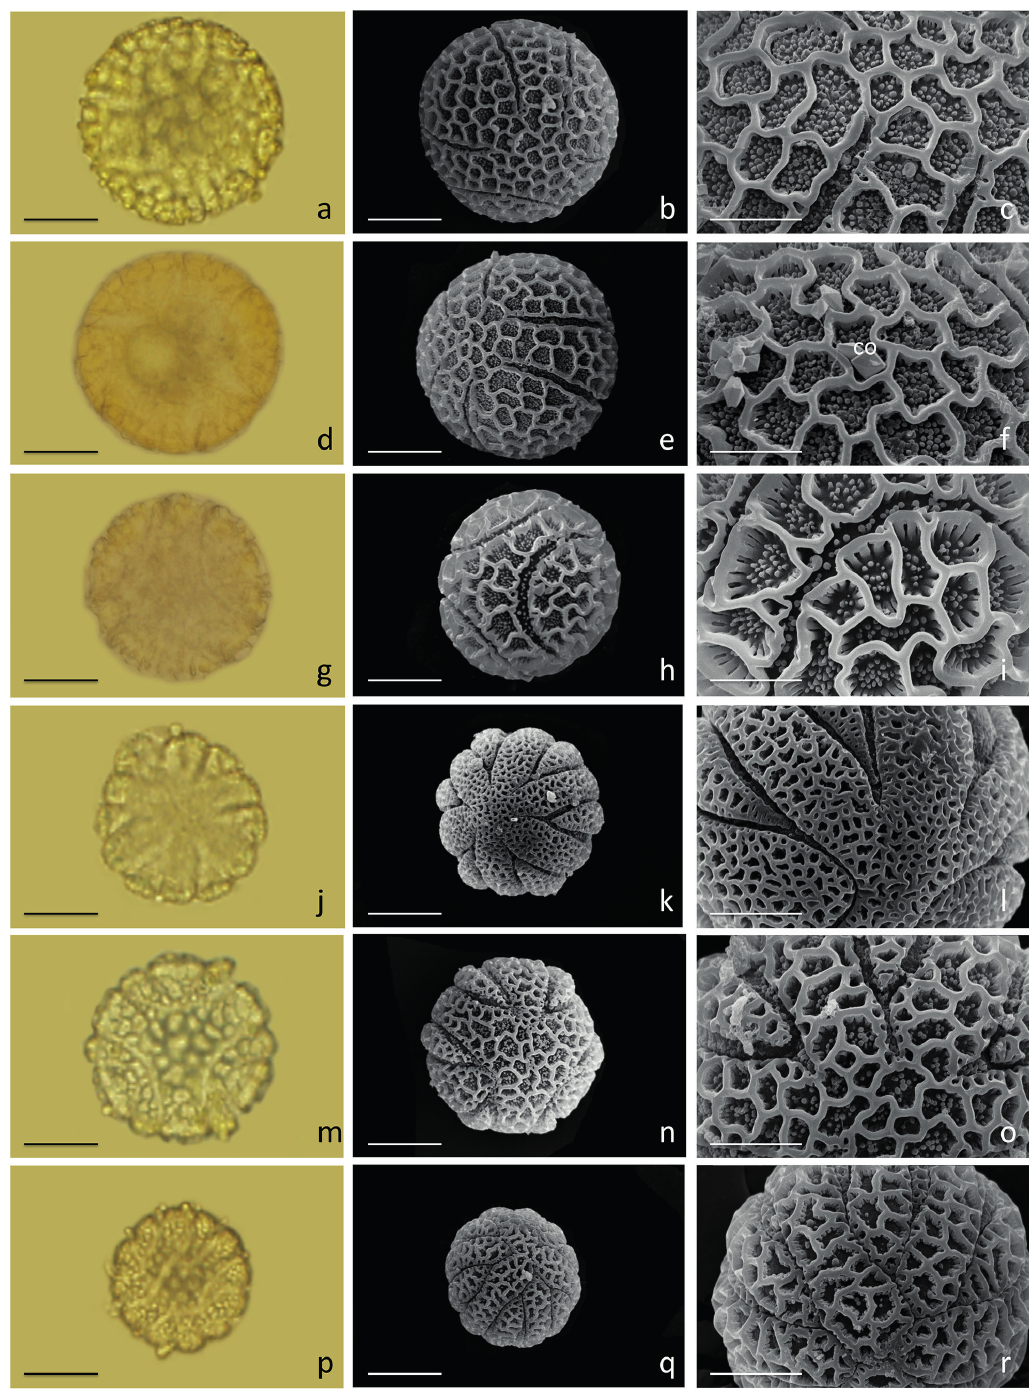
Figure 5 - Pollen grains of Passiflora using a light microscope (LM) and a scanning electron microscope (SEM); a-c ) P. muchronata (BGP-114); d-f ) P. galbana (BGP-109) g-i ); P. coccinea (BGP-408); j-l ) P. suberosa (BGP- 152); m-o ) P. morifolia (BGP-107); p-r ) P. rubra (BGP-125); a, d, g, j, m, p) LM overview; b, e, h, k, n, q) SEM overview; c, f, i, l, o, r) details of the exine and colpi using an SEM. co: calcium oxalate crystals. Bars: a, b, d, e, g, h, j, k, m, n, p, q = 20 μm; c, f, i, l, o, r = 10